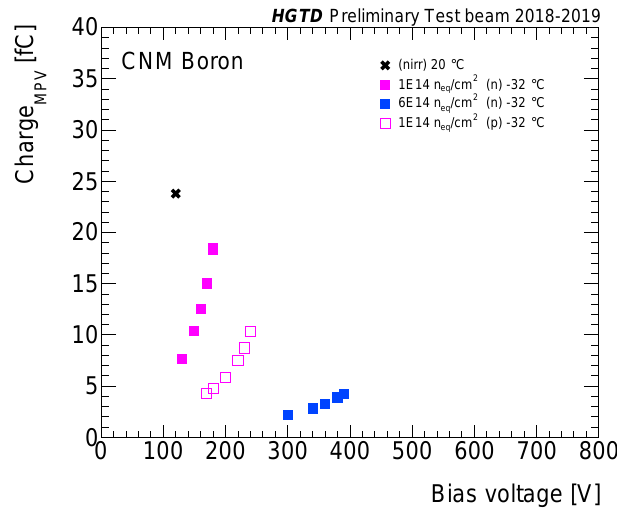
Fig. 9: Time resolution as a function of the bias voltage for different single pad sensors built by HPK